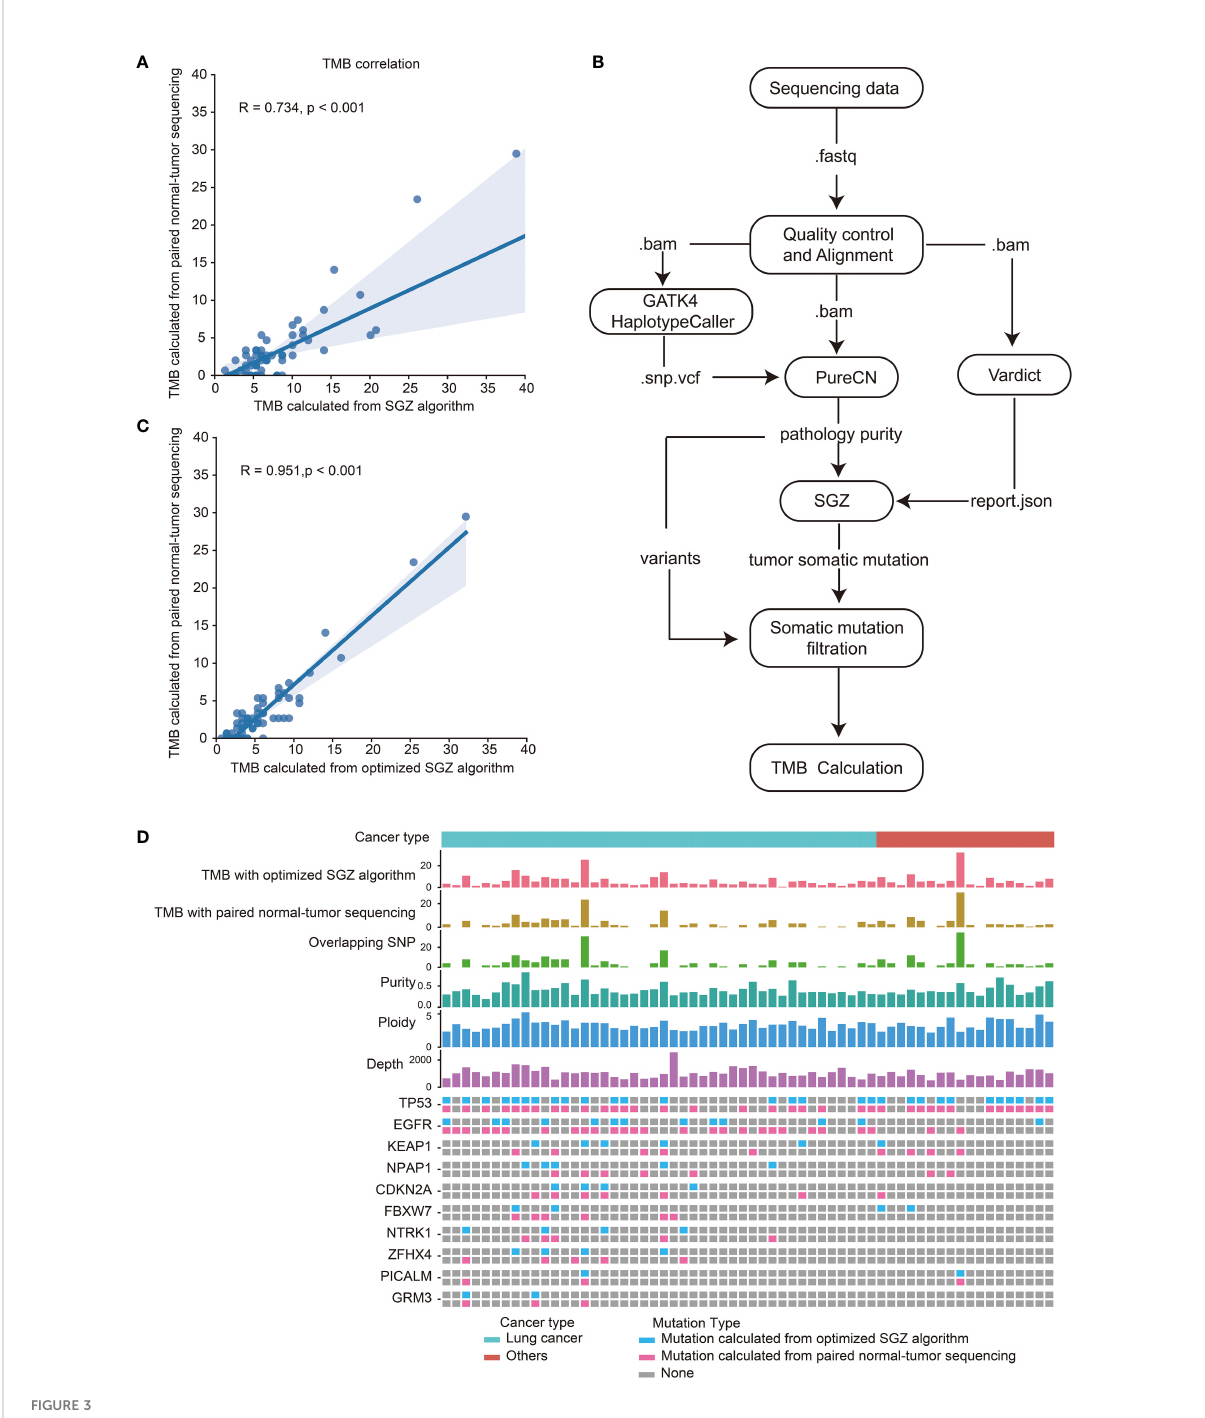
FIGURE 3 High correlation of TMB calculated with optimized SGZ algorithm and paired normal-tumor sequencing in East Asian populations. (A) Correlation of TMB calculated with the SGZ algorithm and the method of paired normal-tumor sequencing. (B) The process of TMB calculation from tumor-only sequencing samples with the optimized SGZ algorithm. (C) Correlation of TMB calculated with optimized SGZ algorithm and the method of paired normal-tumor sequencing. (D) The mutation landscape of sixty-two patients calculated with methods of optimized SGZ algorithm and paired normal-tumor sequencing. The top three histograms are the values of TMB calculated with the optimized SGZ algorithm, TMB calculated with the method of paired normal-tumor sequencing and overlapping SNPs calculated by both methods. Center three histograms are purity, ploidy and sequencing depth of samples. The mutation spectrum of each patient is shown under the value of sequencing depth. The upper row is the mutation detected by the method of paired normal-tumor sequencing, and the lower row is the mutation detected by the method of the optimized SGZ